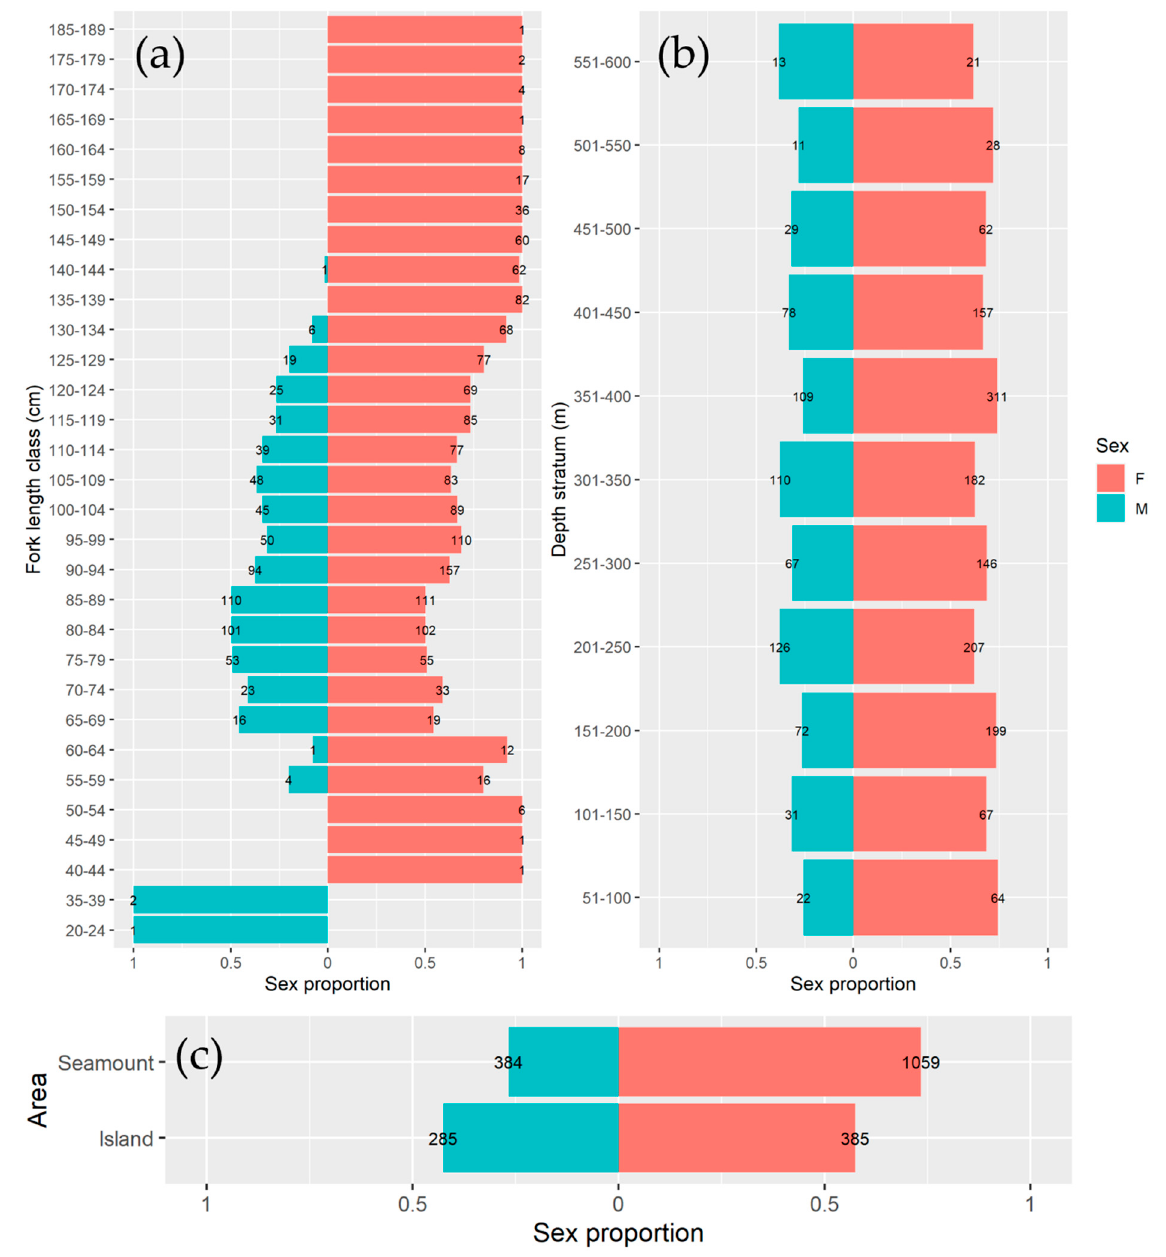
Figure 6. Sex proportion of Lepidopus caudatus in the Azorean waters derived from scientific survey by ( a ) fork length class (FL, cm) ( b ) depth stratum (m) and ( c ) surveyed areas (seamounts vs. islands). The number on the top of each column represents the number of individuals (n). F represents females and M